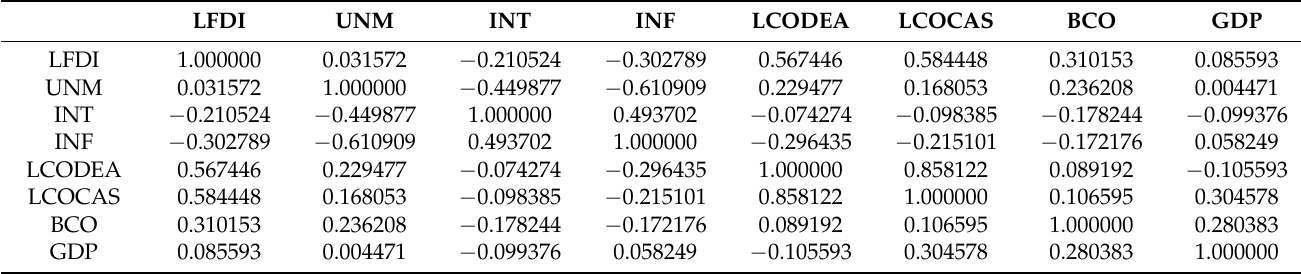
Table 3. Correlation